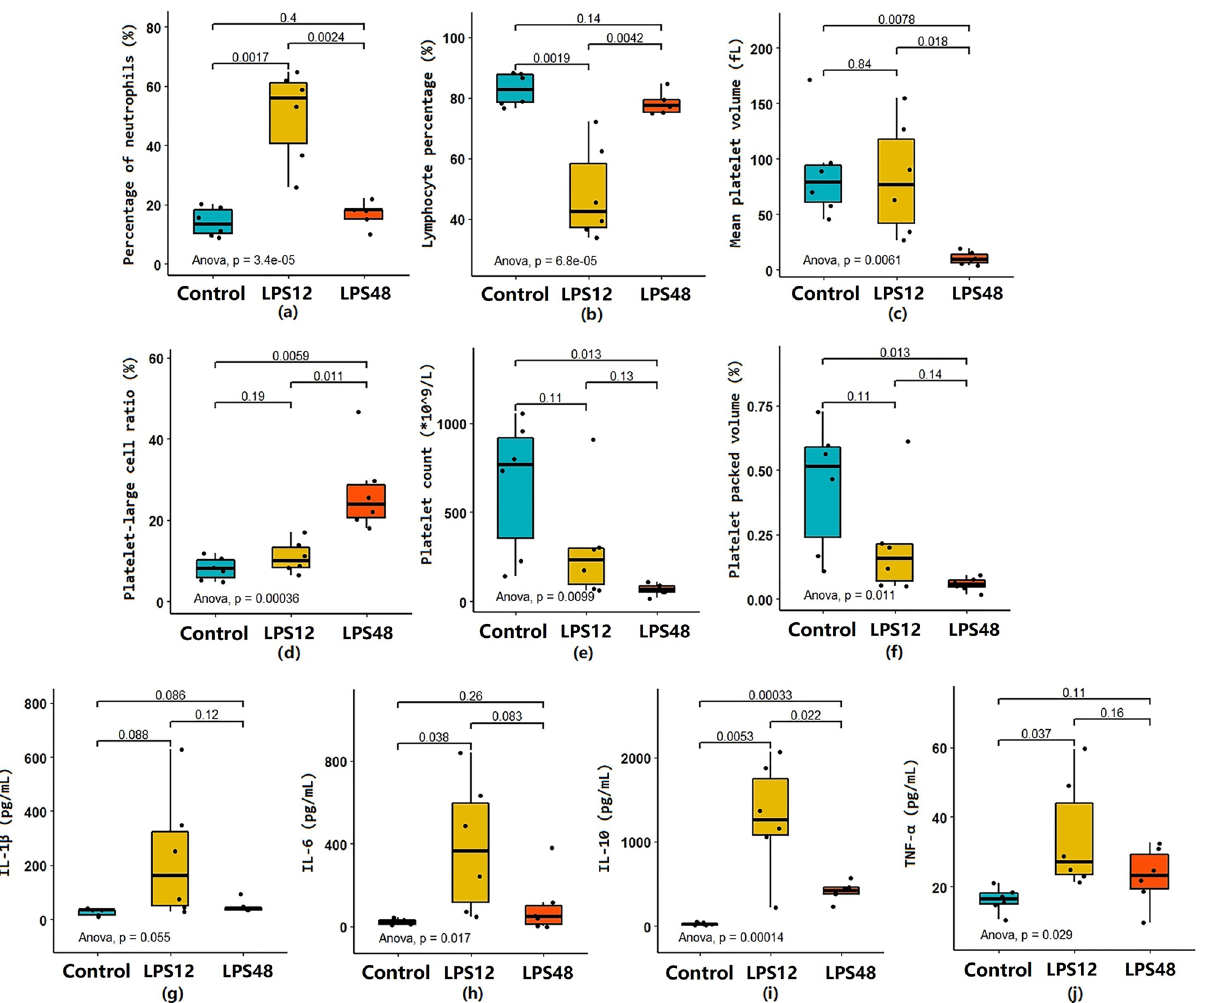
Figure 3. Changes in the routine blood examination parameters and serum cytokine values at indicated time points after LPS injection. Of the 24 hematological parameters examined, six—( a ) percentage of neutrophils (NEU%), ( b ) lymphocyte percentage (LYM%), ( c ) mean platelet volume (MPV), ( d ) platelet/large-cell ratio (PLCR), ( e ) platelet count (PLT), and ( f ) platelet packed volume (PCT)—were significantly changed after LPS challenge. Serum levels of four cytokines—( g ) IL-1β, ( h ) IL-6, ( i ) IL-10, and ( j ) TNF-α—were likewise found to have significantly changed. The 24 hematological parameters were white blood cell count, LYM%, percentage of monocytes, NEU%, percentage of eosinophils, percentage of basophils, absolute lymphocyte value, absolute value of monocytes, absolute value of neutrophils, absolute eosinophils, basophil absolute value, red blood cell (RBC) count, hemoglobin (HB), hematocrit, mean RBC volume, average RBC HB content, mean RBC HB concentration, RBC distribution width coefficient of variation (CV), RBC distribution width SD, PLT, platelet distribution width, MPV, PCT, and